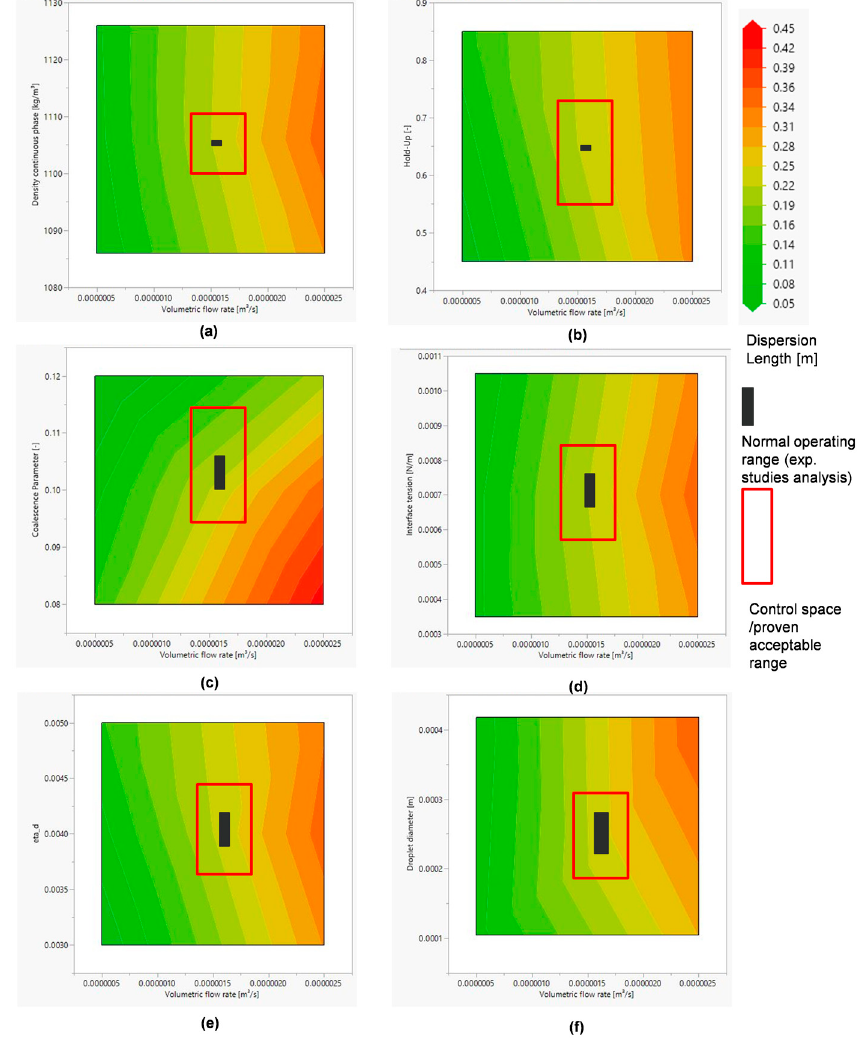
Figure 18. Illustration of the design spaces for density continuous phase ( a ), hold-up ( b ), coalescence parameter ( c ), interface tension ( d ), viscosity disperse phase ( e ), and droplet diameter ( f ) from the OLS analysis of the MFAT simulation study.